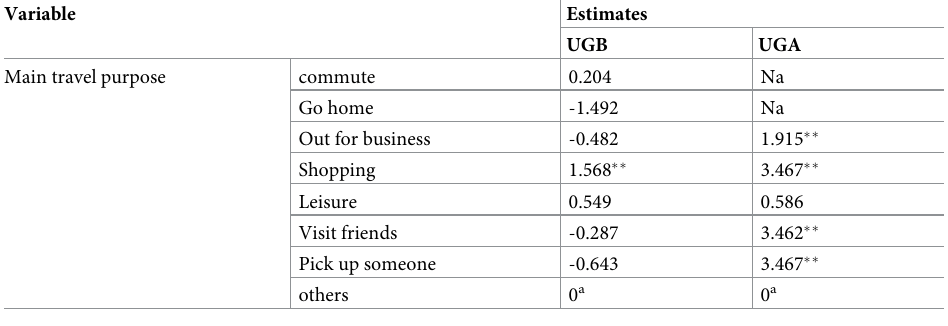
Table 7. Results of ordinal logistic regression on the main travel purpose influence the rental time of UGB and